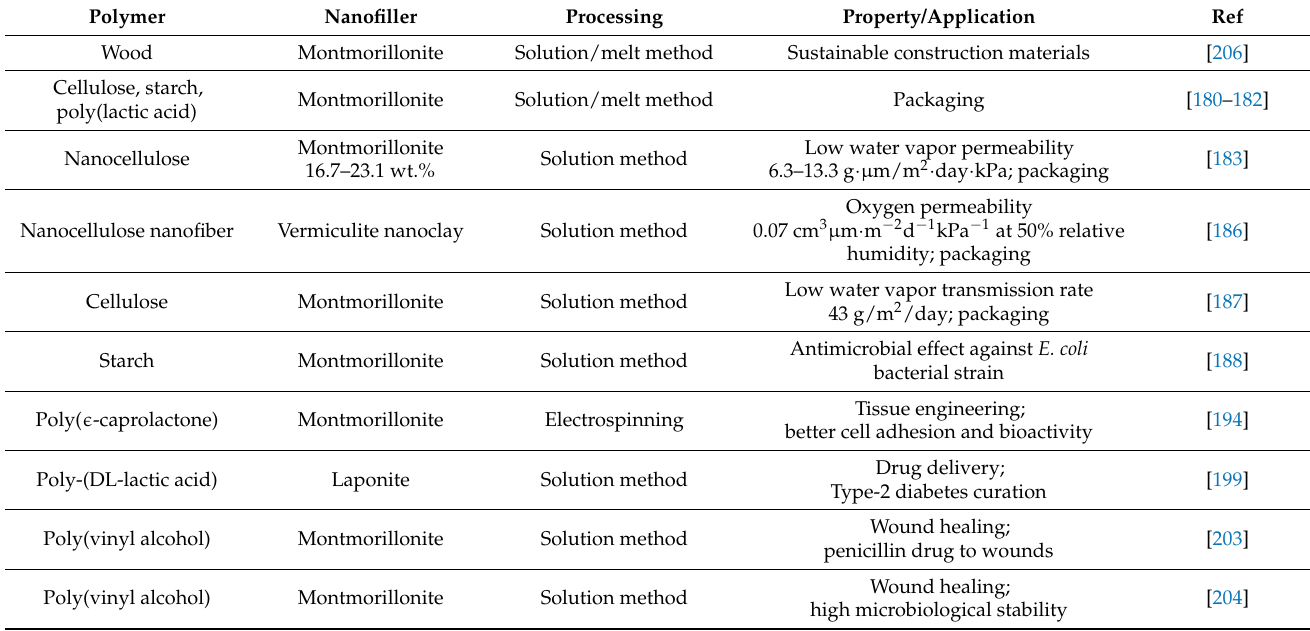
Table 5. Specifications of green nanocomposite systems for technical